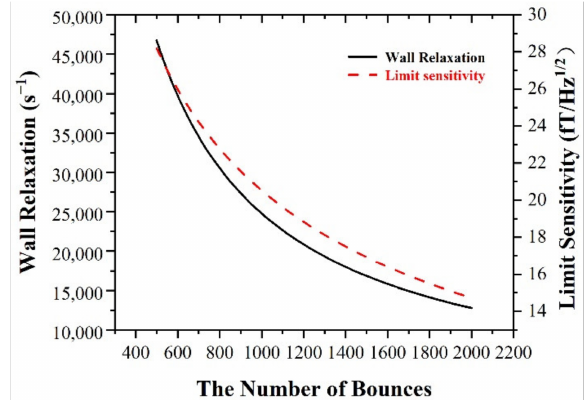
Figure 9. The relaxation of the fiber cell with